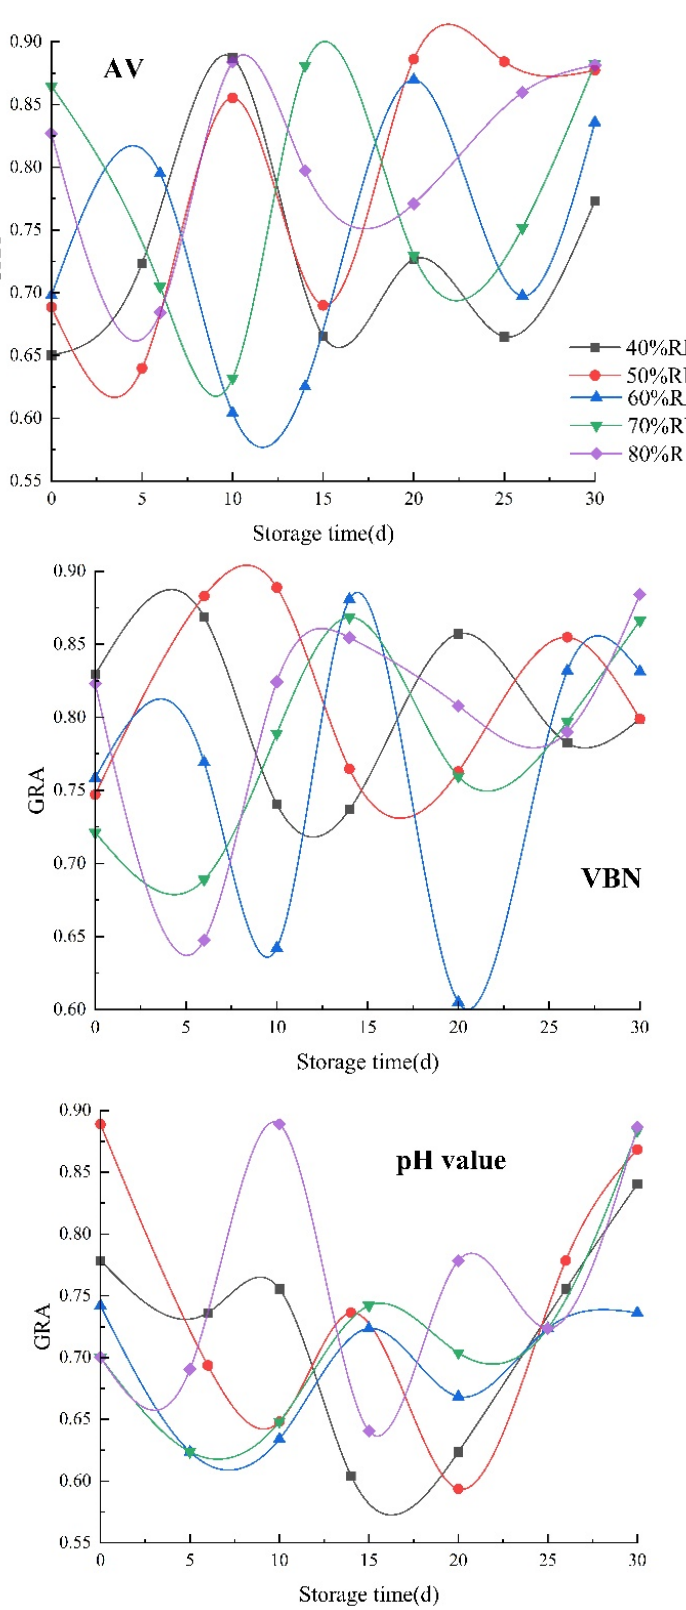
Figure 6. The trend of the GRA between the freshness indexes of fishmeal and mold count during storage under di ff erent RHs.